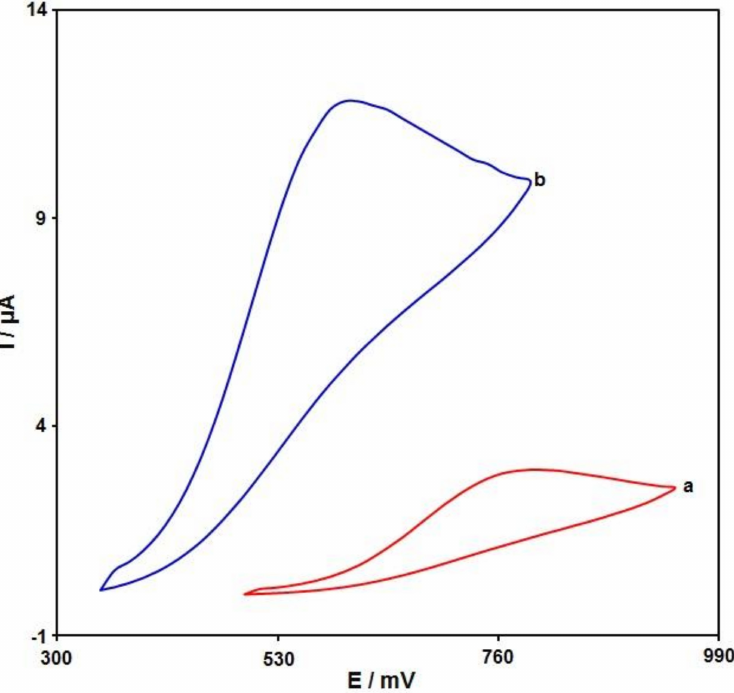
Figure 6. Cyclic voltammograms captured for oxidation of sumatriptan (100.0 µ M) in PBS (0.1 M; pH = 7.0) on (a) unmodified SPE and (b) Ni-Co LDH/SPE with a scan rate of 50 mV/s.